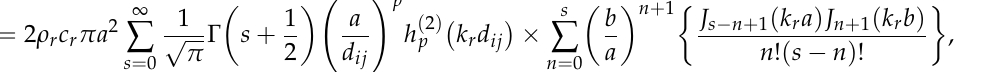
Figure 5. Arrangement of two piston sources.